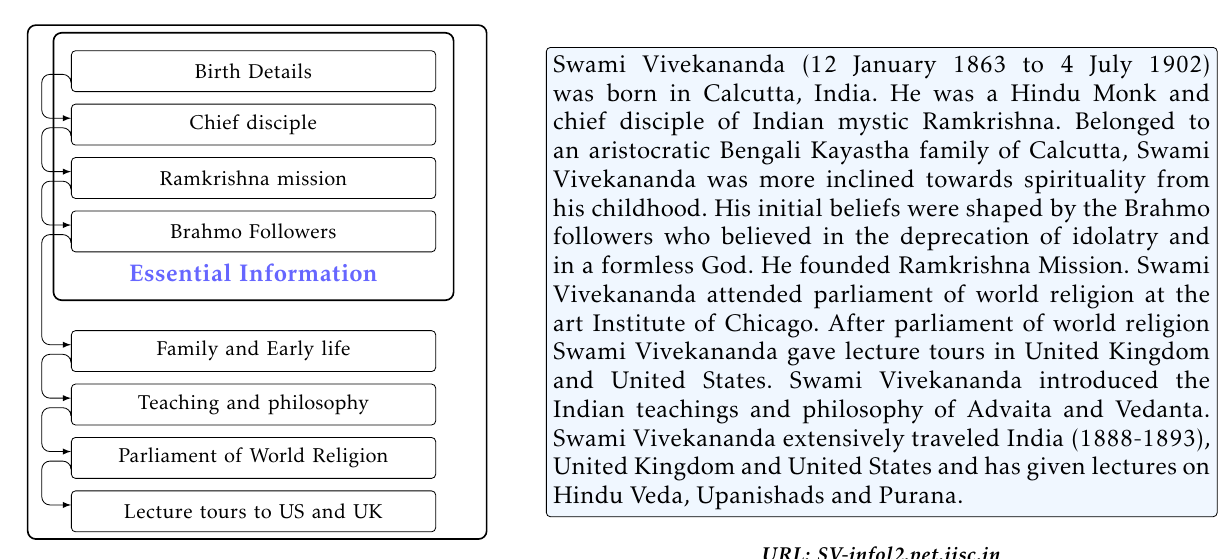
Figure 7. Organized Exhibit Information of Swami Vivekananda at URL: SV-infol2.pet.iisc.in for College Student Ubiquitous Visitors are chosen based on their order of occurrence for a professional ubiquitous